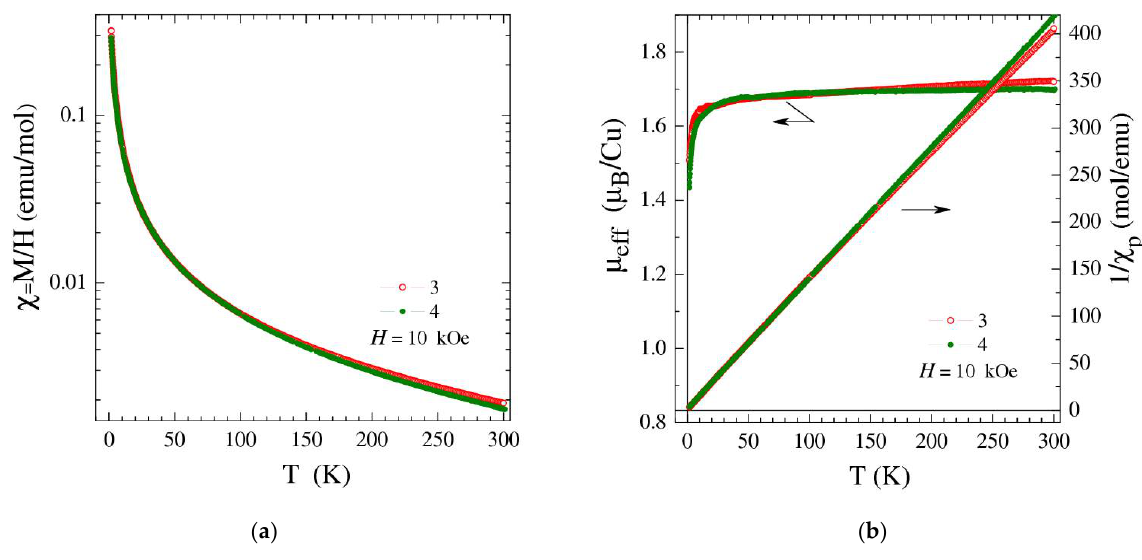
Figure 6. ( a ) Temperature dependences of the magnetic susceptibility χ measured for complexes 3 and 4 at the magnetic field H = 10 kOe. ( b ) Temperature dependences of μ eff and 1/ χ p in complexes 3 and 4 . The depicted effective moment μ eff is calculated for the case of noninteracting magnetic moments ( θ = 0).